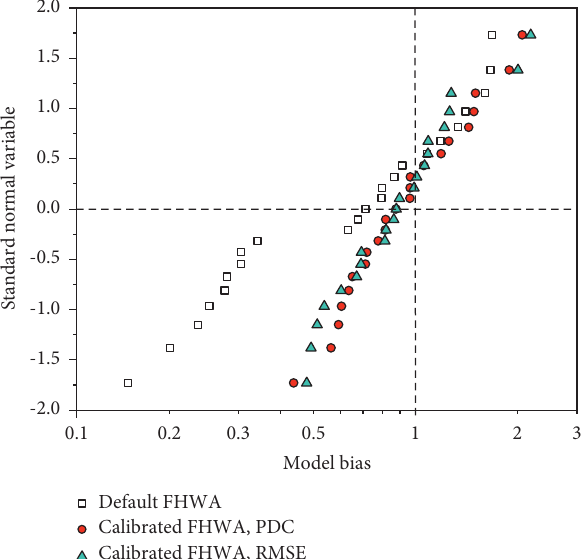
Figure 5: Cumulative distributions of model biases of the default and calibrated FHWA facing load